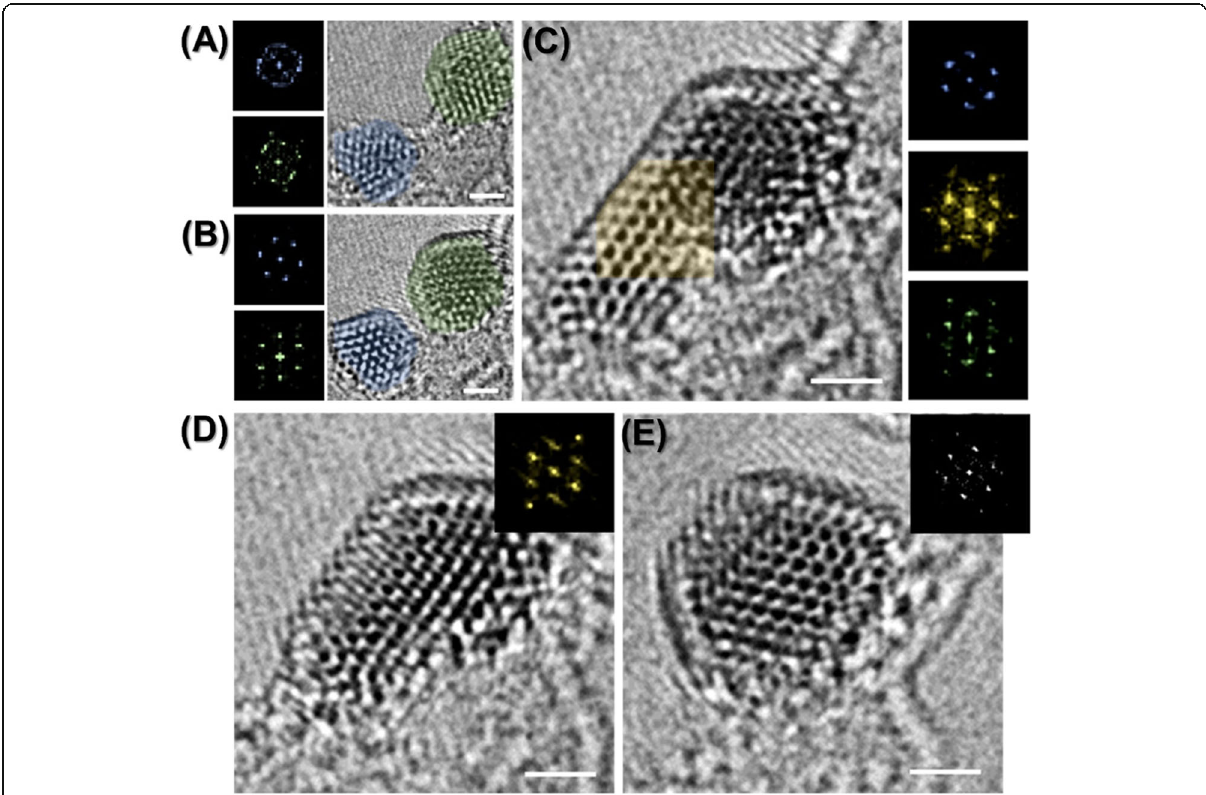
Fig. 1 Atomic resolution TEM images with respect to Ostwald ripening in Cu x O NPs on graphene. All scale bars are 1 nm. a , b Crystallization in Cu x O NPs from the amorphous phase during electron beam irradiation. The gap of acquisition time between a to b is about 6 s. b - d Ostwald ripening process between two Cu x O NPs taken by 0.2 s time-series acquisition. e Crystallized Cu x O NP with hexagonal lattice structures 10 s after taking